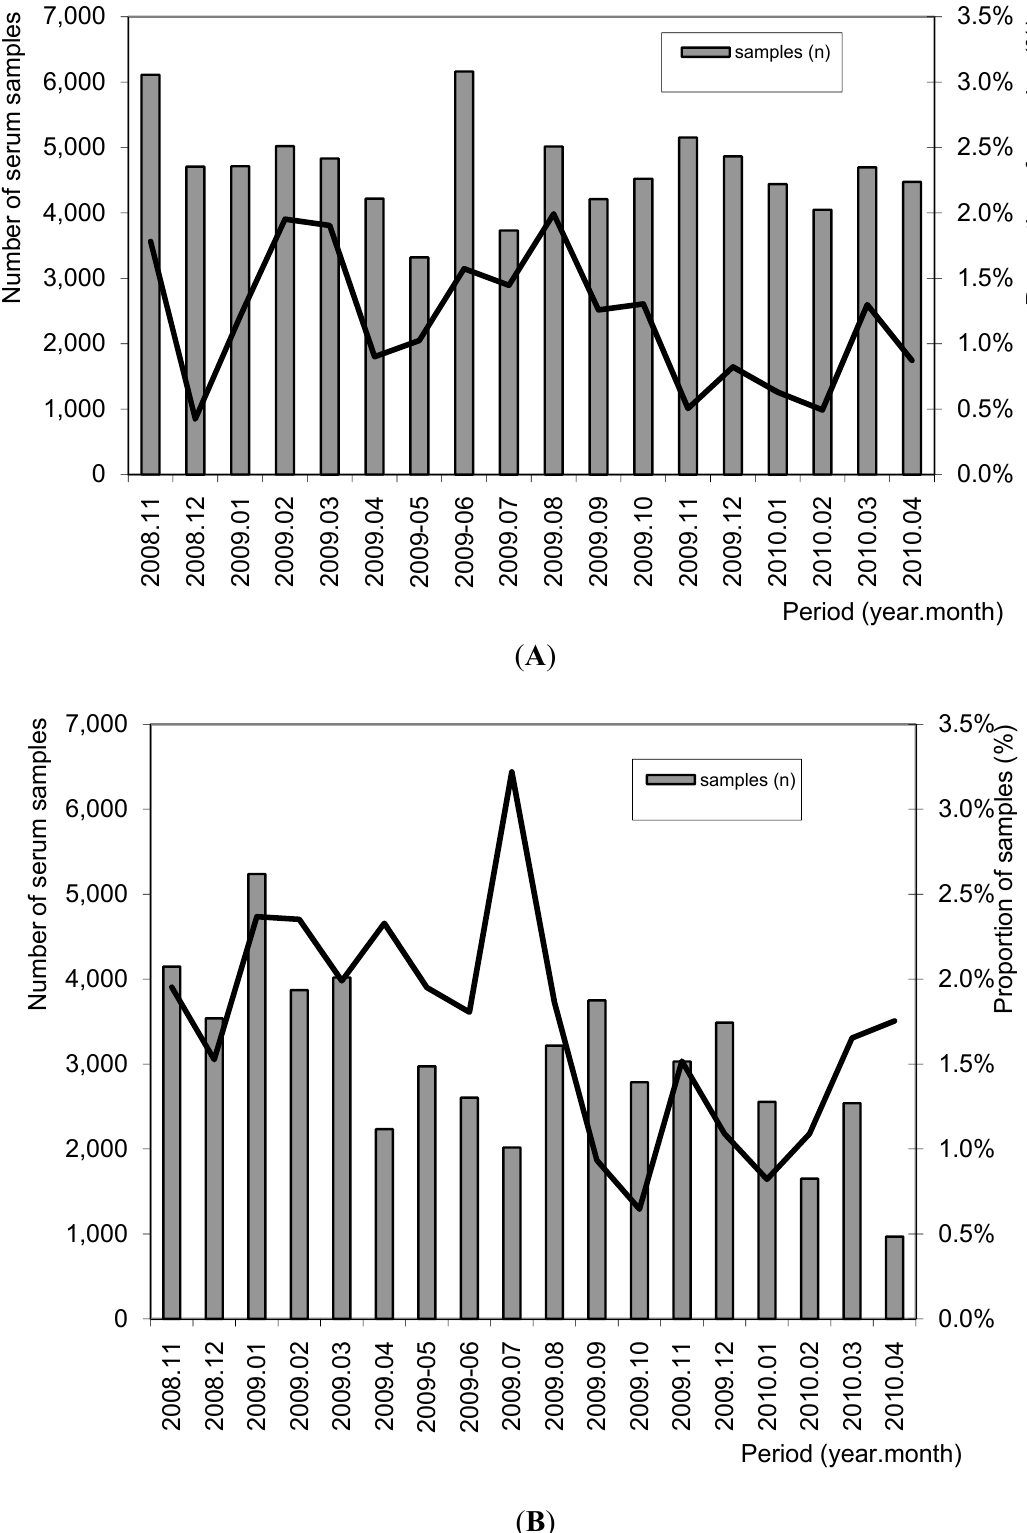
Figure 1 . Proportion of MA-ELISA positive serum samples in relation to the number of tested serum samples in The Netherlands (A) and in Germany (B) in the period